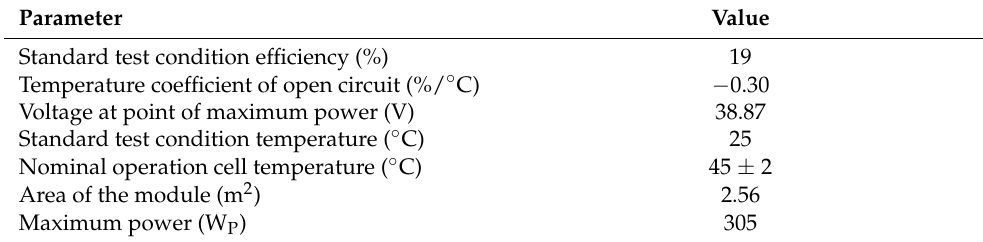
Table 2. Specifications of the selected PV module for the aquavoltaic system.